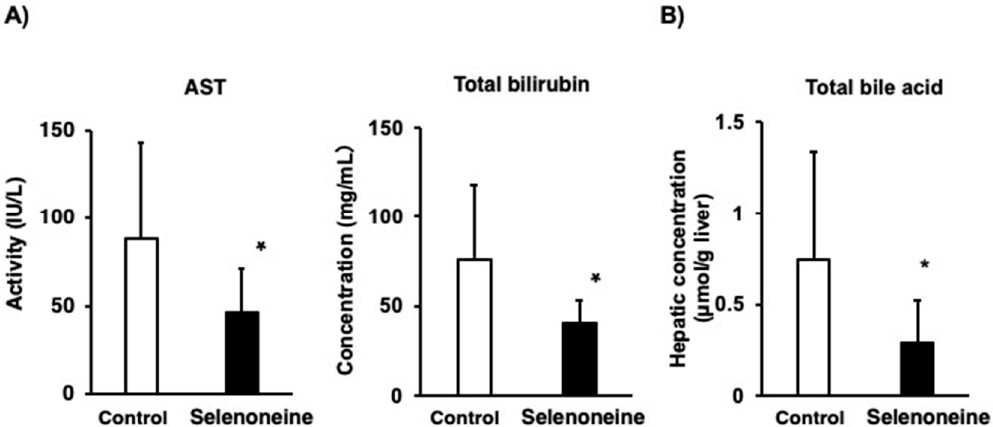
Figure 5. Changes in hepatic damage-associated diagnostic markers. ( A ) Aspartate aminotransferase (AST) and total bilirubin. ( B ) Total bile acid. Mice were supplemented with 0.3-mg Se/kg selenoneine for 4 months. Values are presented as mean ± SD ( n = 8). Significant differences were assessed using Student’s t-test (*, p < 0.05 vs. corresponding control mice).